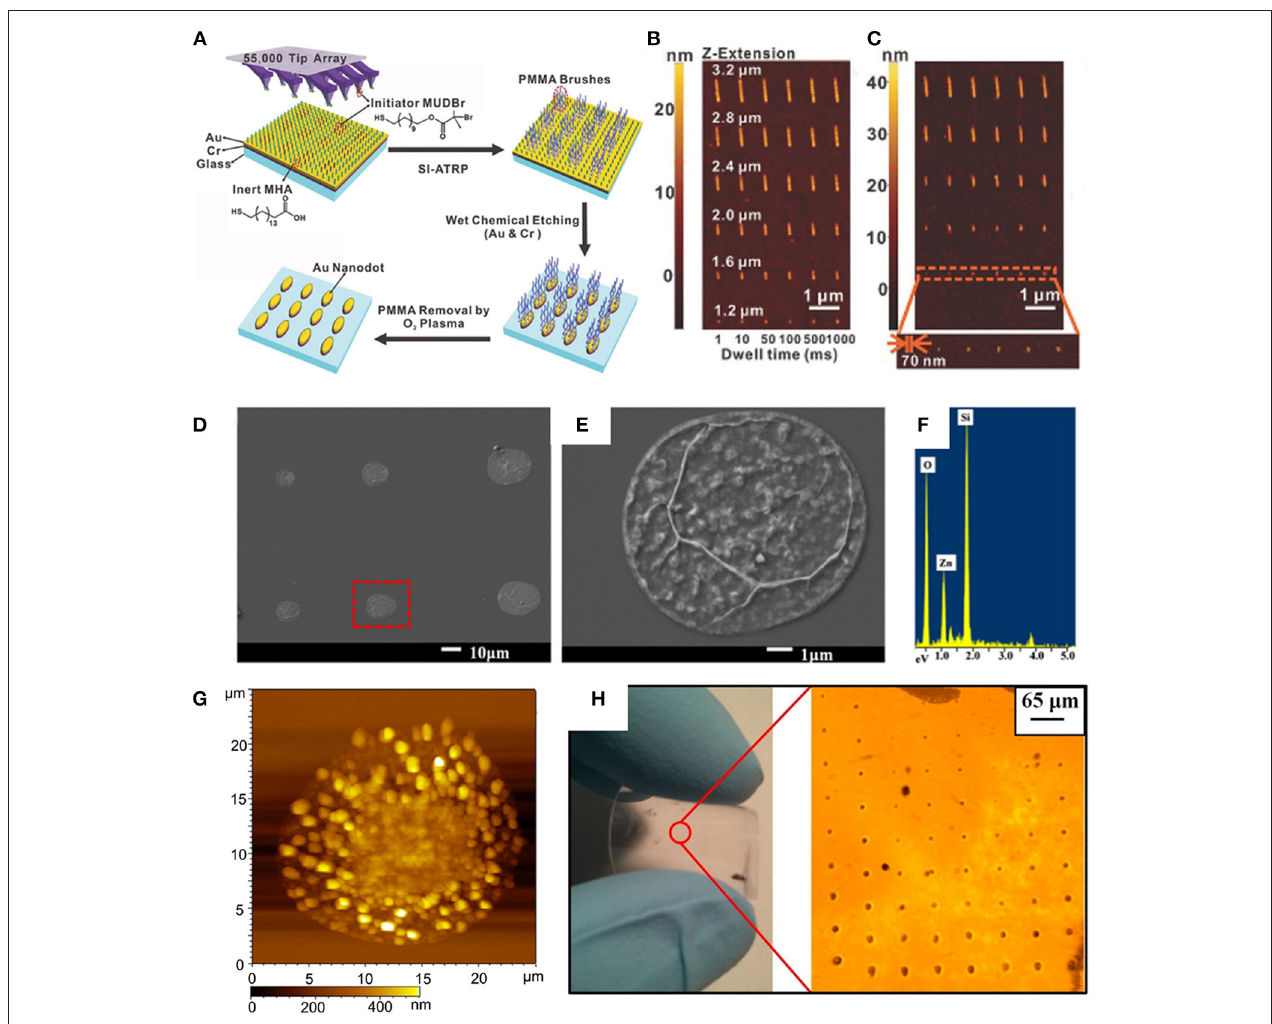
FIGURE 4 | (A) The fabrication of Au nanostructures, by parallel dip-pen nanodisplacement lithography, surface-initiated atom transfer radical polymerization and wet-chemical etching. (B,C) AFM topography of PMMA brushes and the Au structures (Chen et al., 2017). Reproduced with the permission of WILEY-VCH Verlag GmbH & Co. KGaA, Weinheim. (D) SEM images of ZnO array. (E) Magnified image of SEM image. (F) Energy Dispersive X-Ray (EDX) Spectrum of ZnO dot in (E) . (G) AFM image of the ZnO dot. (H) Digital image of the bent polyethylene naphthalate (PEN) substrate with deposited ZnO dot array ( Cronin et al., 2014). Reproduced with the permission of 2018 Elsevier